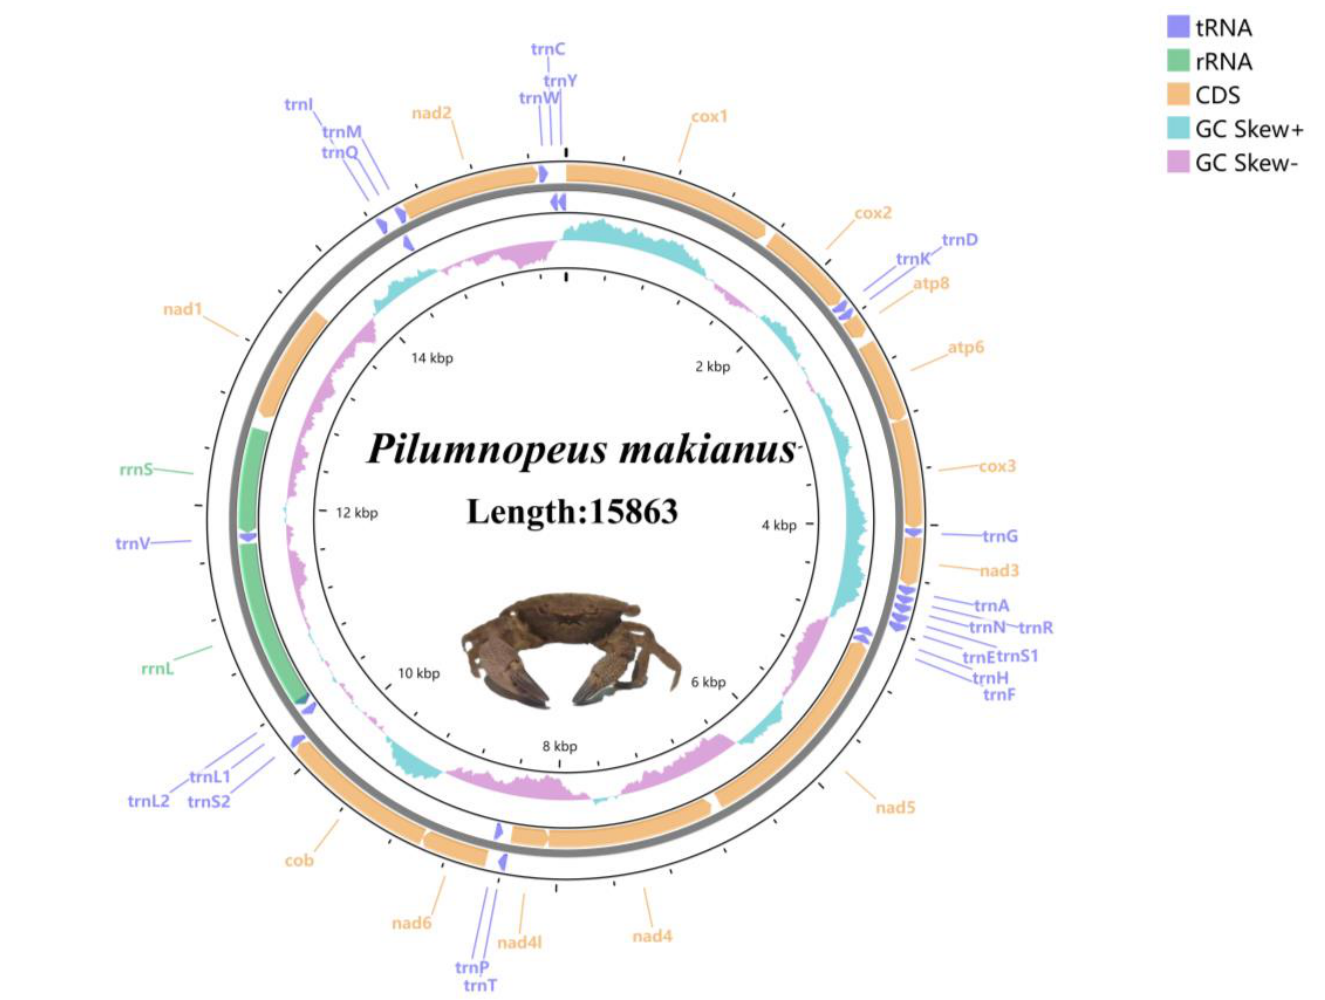
Figure 1. Mitogenome map of the P. makianus . Lavender arrows represent tRNA, green arrows represent rRNA, and yellow arrows represent CDS. Blue represents GC skew + and pink represents GC skew.